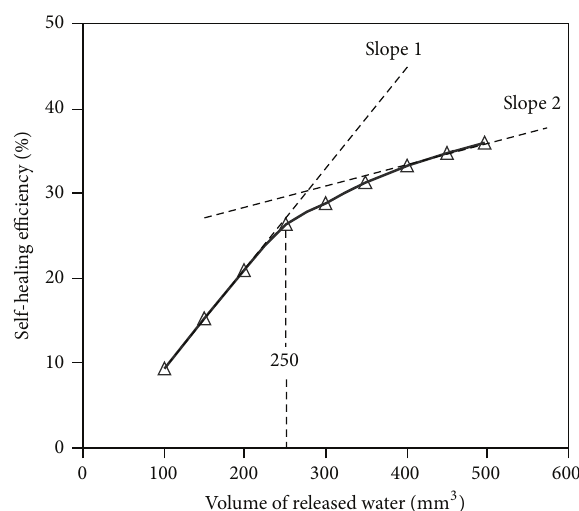
Figure 5: Efficiency of self-healing of a crack with the size of 40 mm (length) × 40 mm (depth) × 10 𝜇 m (width) versus different amount of extra water supplied to the crack via capsules